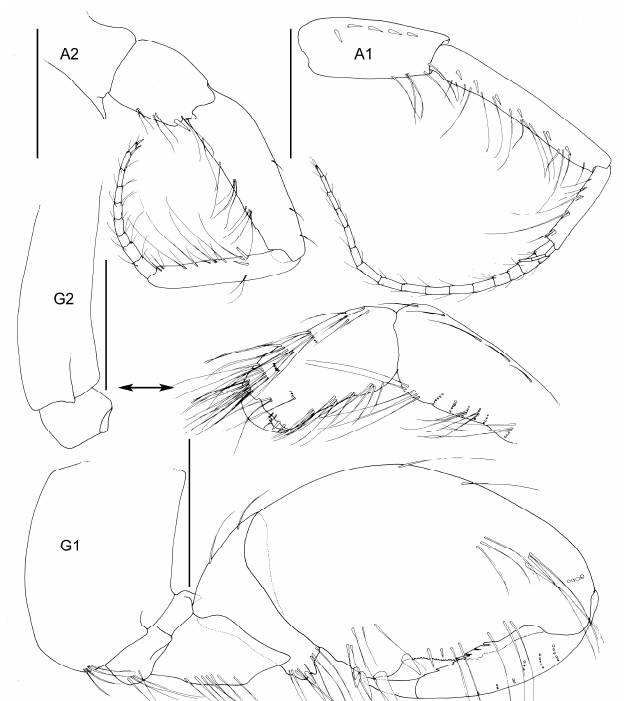
Figure 6. Unciola conchicola sp. nov. holotype male, 10 mm, ZMHK-62083, South Island, Iceland Basin, 1921 m. Scale: 0.5 mm.